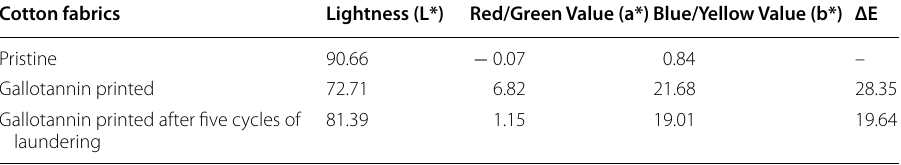
Table 1 Color revelation characteristics of gallotannin printed cotton fabrics Cotton fabrics